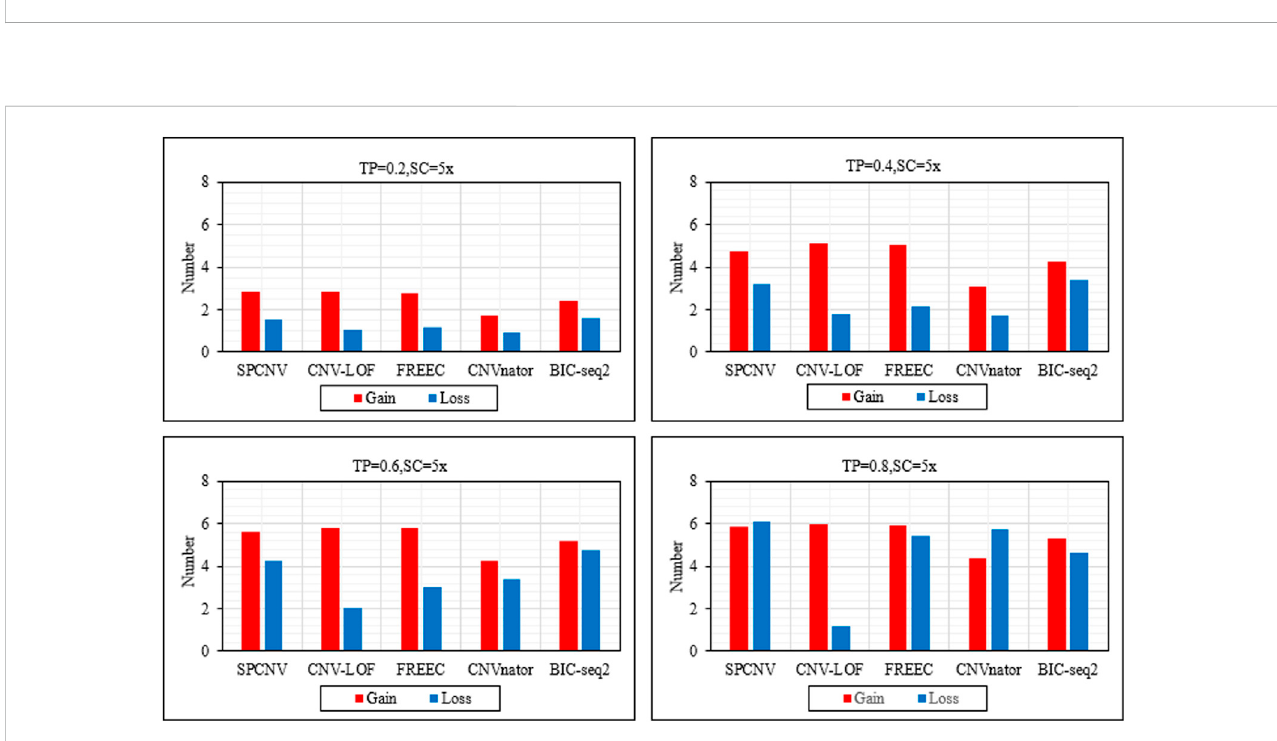
FIGURE 4 The performance of the fi ve methods is compared in terms of the number of detected gains and losses across four sets of simulation samples. The equations on the left and right sides of the comma represent the tumor purity (TP) and sequencing coverage (SC), respectively.